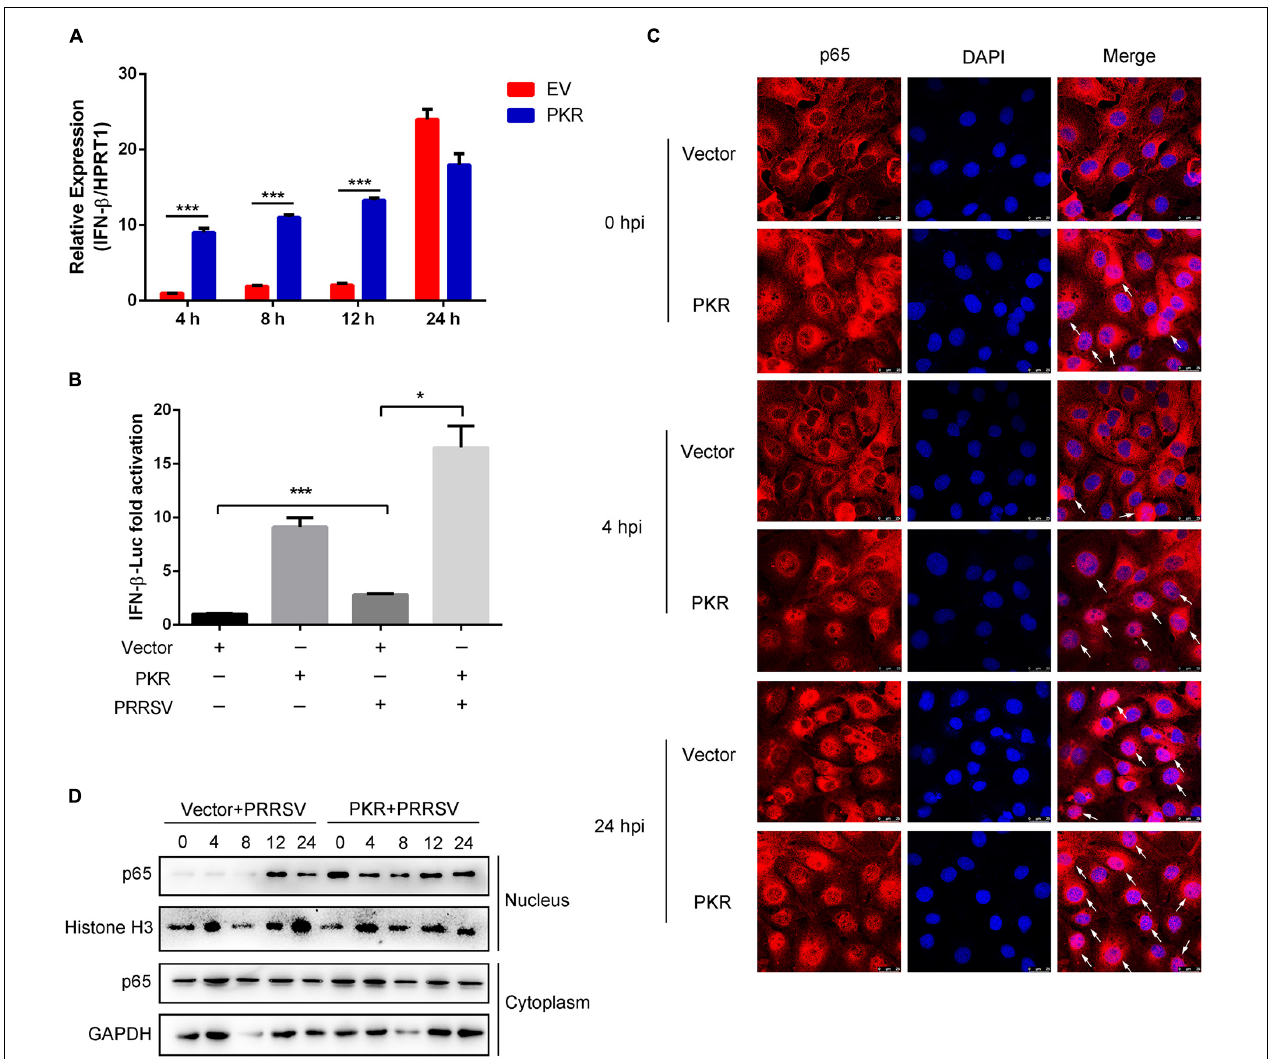
FIGURE 6 | PKR promotes activation of NF- κ B and interferon response. (A) Marc-145 cells were transfected with empty vector or Myc-tagged PKR plasmid, and then cells were infected with PRRSV (MOI = 1) for indicated post-infected time. qRT-PCR was used to measure the mRNA expression of IFN- β at 4, 8, 12, and 24 hpi. (B) Marc-145 cells were mock-infected or infected with PRRSV in the presence or absence of PKR overexpression. The activation of the IFN- β promoter was shown using dual-luciferase reporter assays. (C) Immunofluorescence analysis of p65 nuclear translocation. Marc-145 cells were transfected with empty vector or PKR plasmid and infected PRRSV for 0, 4, and 24 h. Cells were fixed and stained for NF- κ B p65 followed by an Alexa fluor 555-conjugated anti-rabbit IgG (red). Nuclei were counterstained with DAPI (blue). White arrows represented p65 nuclear translocation. Bar = 25 µ m. (D) Marc-145 cells were transfected with empty vector or PKR plasmid and infected PRRSV. At the time 0, 4, 8, 12, and 24 hpi, cells were harvested, and nuclear/cytosol fractionation assay was performed. Western blots are shown to detect NF- κ B p65. Histone H3 is used as an internal nuclear control, and GAPDH serves as a cytoplasmic internal control. Data are the results of three independent experiments (means ± SE). Significant differences are denoted by * p < 0.05, ** p < 0.01, and *** p <